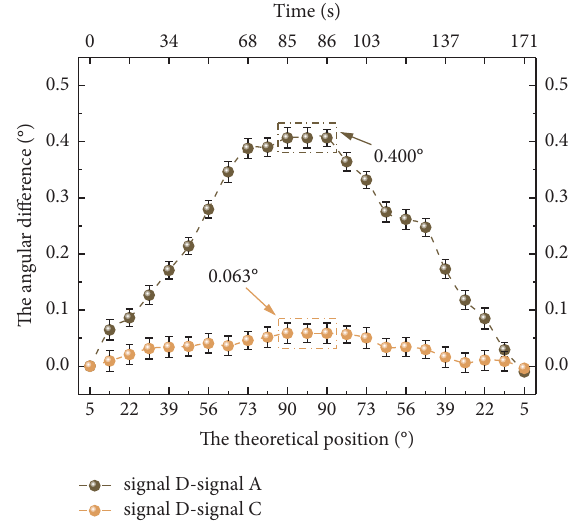
Figure 6: Te angle diference of the single-motor drive (5 ° ∼ 90 ° ∼ 5 °